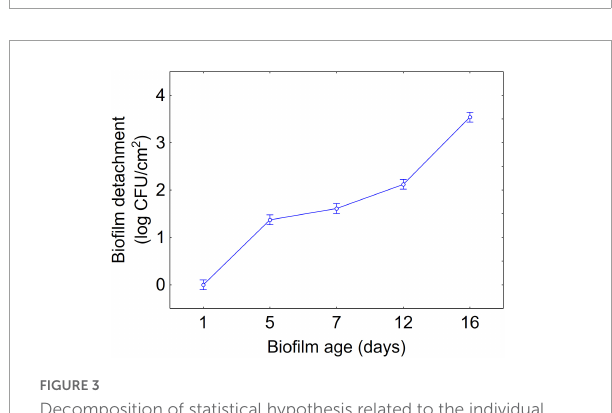
FIGURE3 Decomposition of statistical hypothesis related to the individual term of biofilm age on the detachment of biofilm (log CFU/cm 2 ) of L. plantarum c19 and DSM 1055. Mean values ± 95% confidence